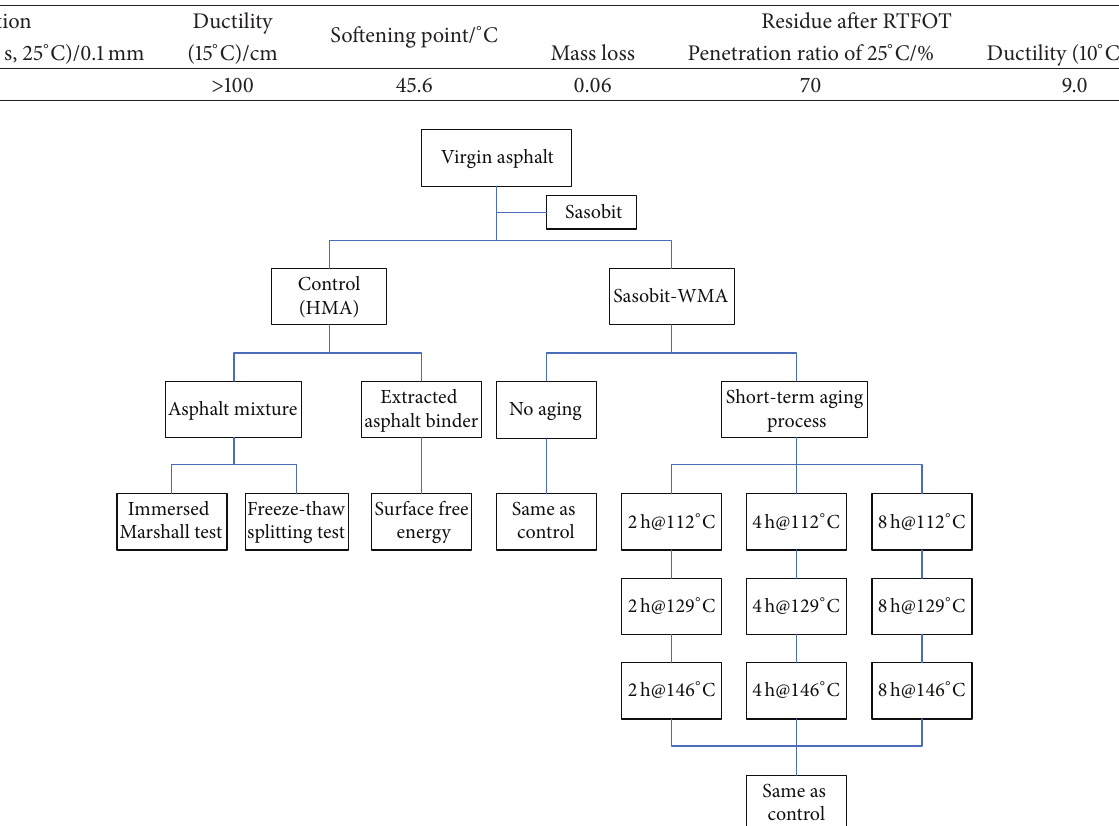
Table 1: Properties of the three asphalt binders.